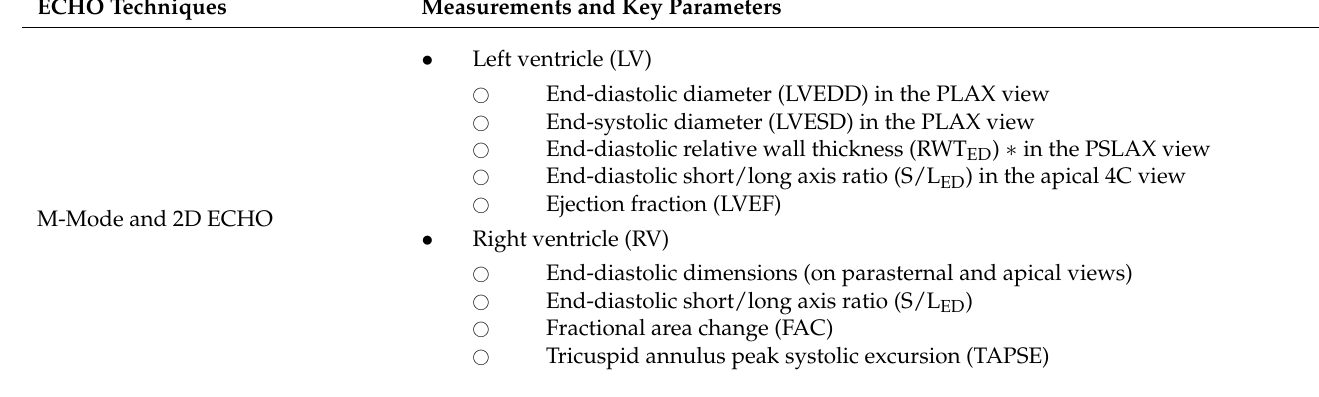
Table 3. Echocardiographic measurements and measurement-derived parameters for evaluation of cardiac recovery during off-pump/pump turn-down trials. Reprinted with permission from Ref. [42]. Copyright 2019